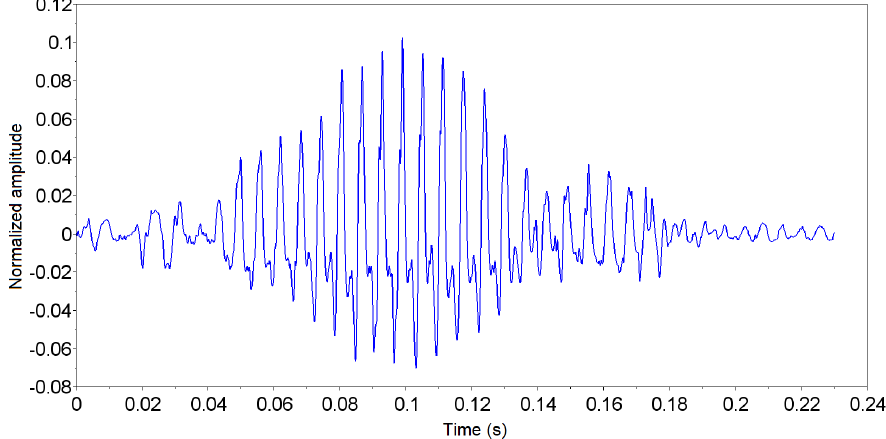
Figure 23. Ceratitis capitata passing event signal of the standard